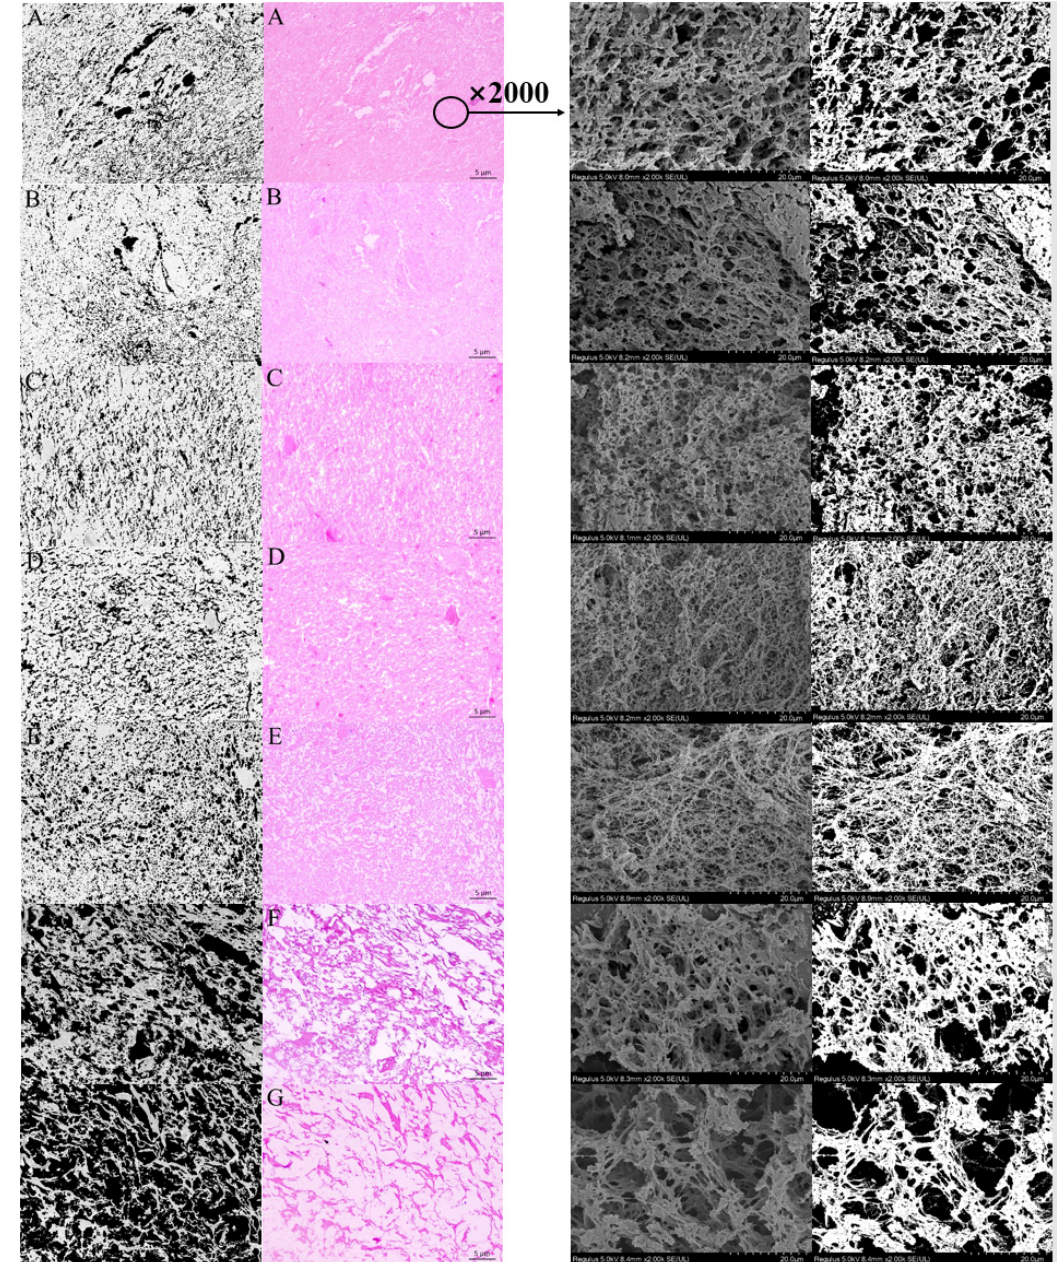
Figure 2. Micrograph images (400×) and the corresponding threshold binary images of the compo- site gels ( left ); SEM images (2000×) and the corresponding threshold binary images of the MP gel gels ( left ); SEM images (2000 × ) and the corresponding threshold binary images of the MP gel network network ( right ). ( A ): the control; ( B ): MP with 0.05%CG; ( C ): MP with 0.1% CG; ( D ): MP with 0.2% ( right ). ( A ): the control; ( B ): MP with 0.05% CG; ( C ): MP with 0.1% CG; ( D ): MP with 0.2% CG; CG; ( E ): MP with 0.4%CG; ( F ): MP with 0.8% CG; ( G ): MP with 1.2% CG. ( E ): MP with 0.4% CG; ( F ): MP with 0.8% CG; ( G ): MP with 1.2%